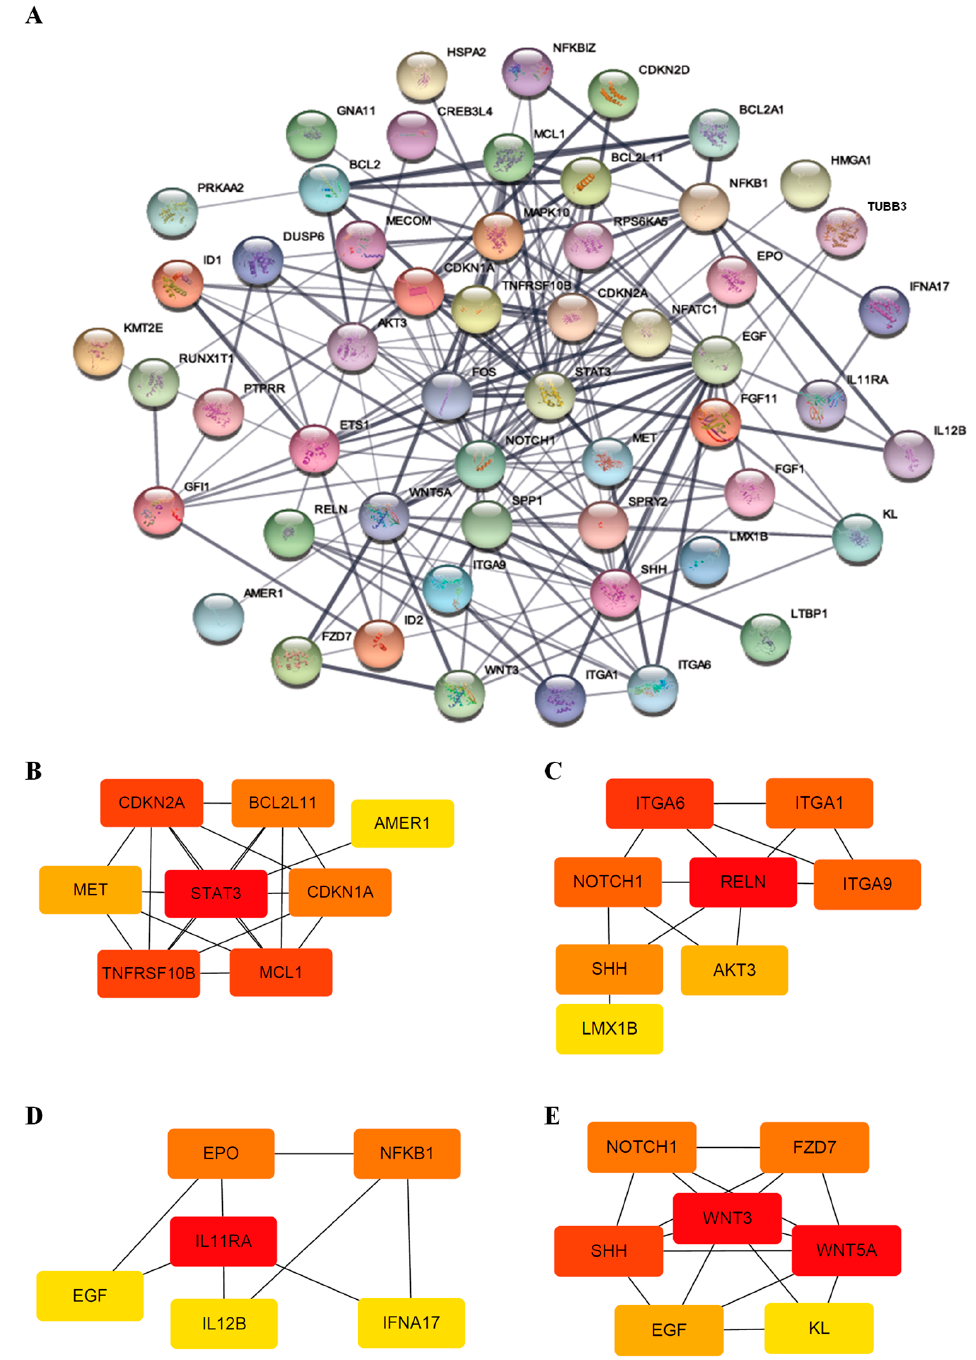
Figure 3. PPI network and subnetworks generated from DEGs. ( A ) The PPI network was processed using the STRING plug-in of the Cytoscape program (version 3.8.2). Each circle represents a gene (node), and connections between circles (edges) represent direct or indirect interactions. Of the 66 genes that were differentially expressed between F-36P cells and F-36P/DEC cells, 54 were functionally linked with 198 edges. PPI enrichment p -values < 0.04 were considered significant. ( B–E ) Module analyses. Module clusters were extracted using MCODE and cytoHubba analyses. Hub genes are indicated in red, and co-expressed genes are indicated in orange, yellow, or blue according to their degree of importance. Module 1 ( B ) contains 8 nodes and 20 edges. Module 2 ( C ) contains 8 nodes and 13 edges. Module 3 ( D ) contains 6 nodes and 8 edges. Module 4 ( E ) contains 7 nodes and 16 edges.